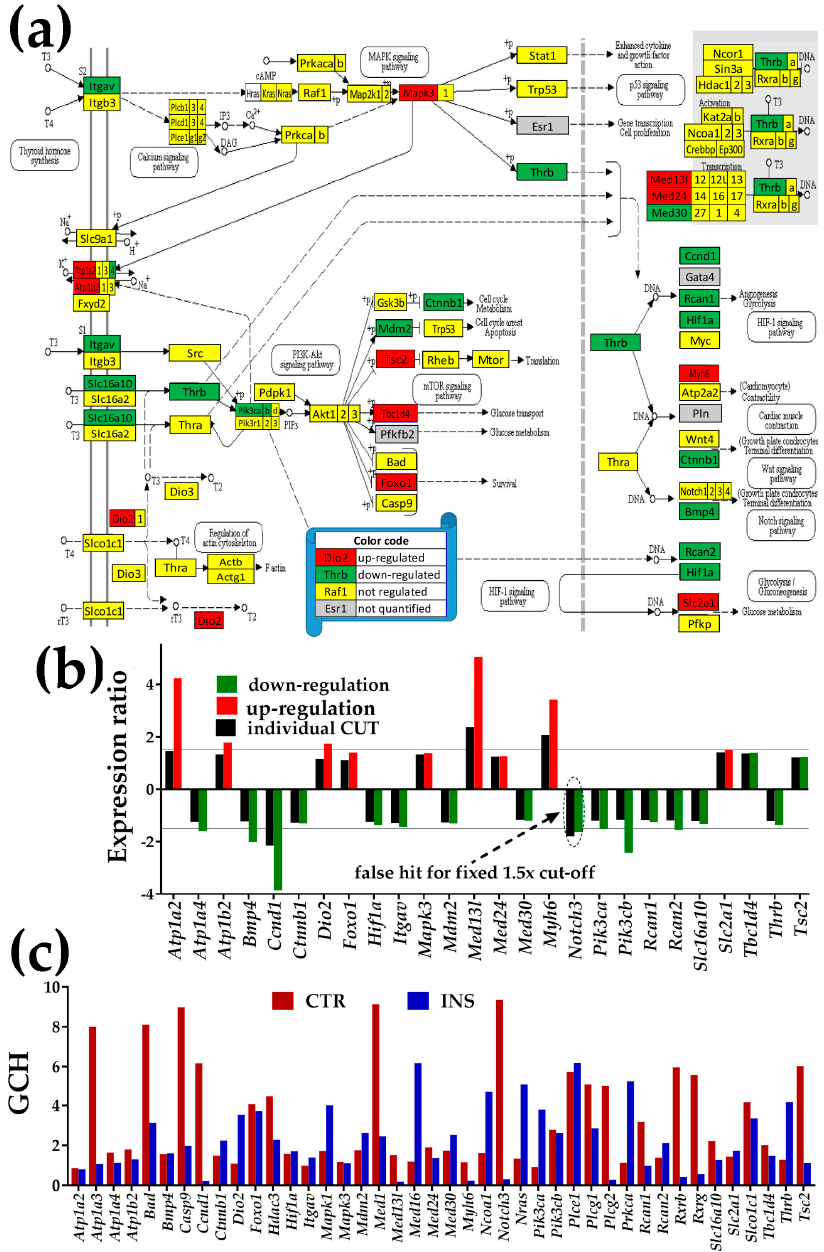
Figure 6. Proximity of non-touching Oli-neu cells affects the thyroid hormone signaling pathway (modified from http://www.kegg.jp/pathway/mmu04919). (a) Significantly regulated genes . (b) Expression ratios and individual fold-change cut-offs (negative for down-regulation) of the significantly regulated genes. Note that Notch3 would be a false hit if the traditional 1.5x would be used instead of our individual gene cut-off because although the absolute expression ratio exceeded 1.5x it was below the individual gene CUT. (c) Gene Commanding Height (GCH) scores of selected TH genes. In addition to the significantly regulated TH genes, we plotted genes with high GCH scores in one condition: Na + /K + transporting , alpha 3 polypeptide ( Atp1a3 ), B cell leukemia/lymphoma 2 (BCL2)-associated agonist of cell death ( Bad ), caspase 9 (Casp9), subunits of mediator complex ( Med1, Med16 ), notch 3 ( Notch3 ), parathyroid hormone 1 receptor ( Pth1r ), regulators of calcineurin ( Rcan1, Rcan2 ), and thyroid hormone receptor-associated protein 3 ( Thrap3 ).